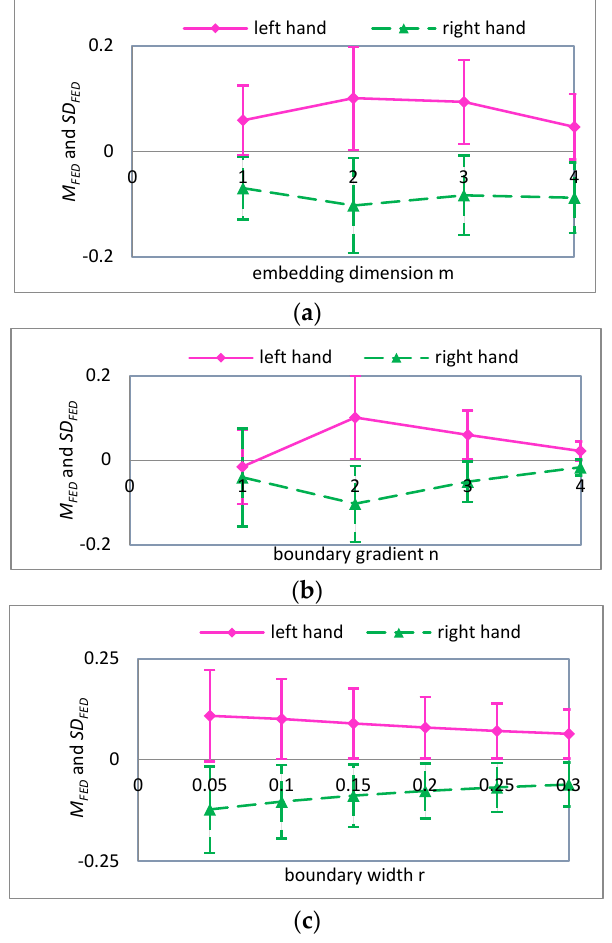
Figure 7. For =2 τ , the mean and standard deviation of FED curves for input variables ( a ) Figure 7. For τ = 2, the mean and standard deviation of FED curves for input variables ( a ) embedding embedding dimension m ; ( b ) boundary gradient n ; and ( c ) boundary width r . dimension m ; ( b ) boundary gradient n ; and ( c ) boundary width r